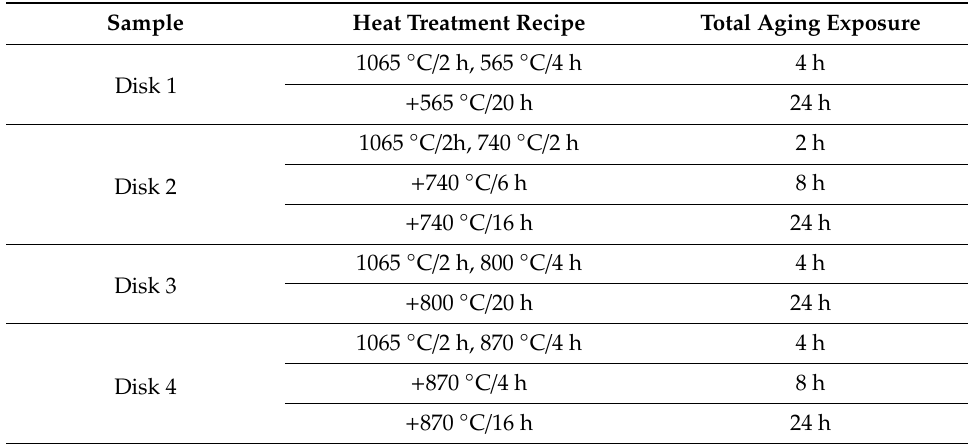
Table 4. List of the post-process heat treatment recipes and total aging exposure time applied for the study on the aging response of selective laser melting (SLM) Inconel